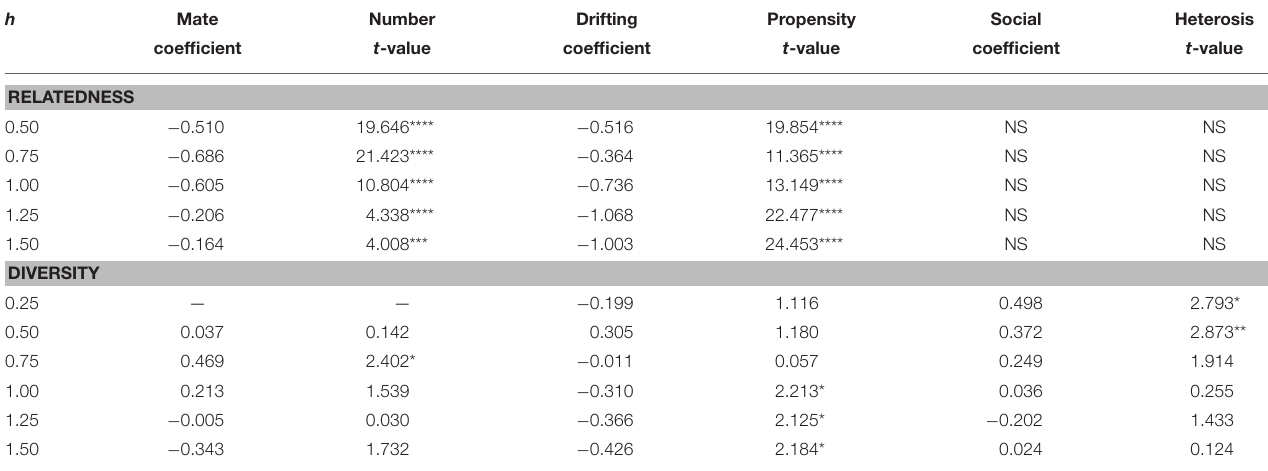
The levels of within-group relatedness between workers or genetic diversity are regressed against mating behavior (m), drifting/acceptance thresholds (d), and expression of social heterosis (y), as the relative strength of social heterosis (h) increases. For relatedness, social heterosis expression never had a significant effect and was removed from the analyses. When h = 0.25, all populations evolved to be fixed for monandry. ( * P < 0.05, ** P < 0.01, *** P < 0.001, and **** P < 0.0001).